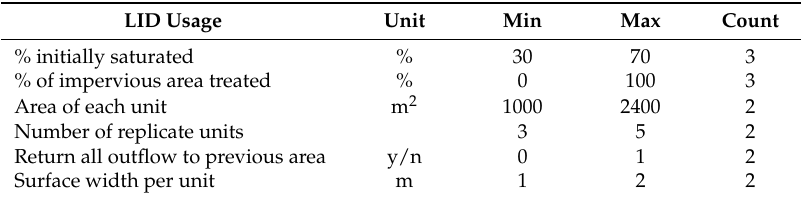
Table 5. Entered values for generating LID planning scenarios (step 9 of the WMAM).